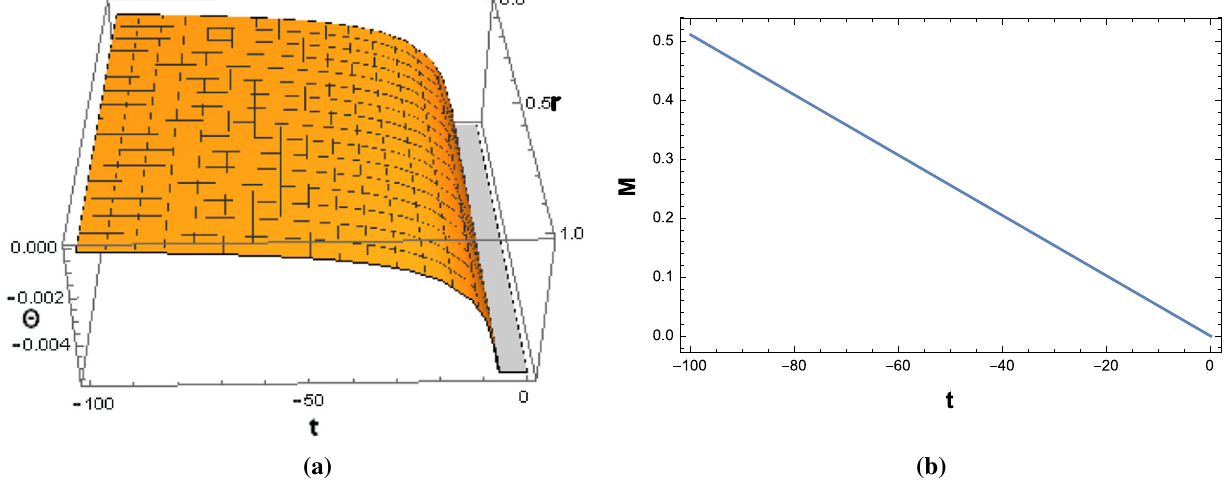
Fig. 5 a – c Shows the plots of the heat flux q (65) w.r.t. time t and radial r coordinates for f ( R ) = R + λ R 2 with λ = 5, f ( R ) = R 1 + (cid:3) with (cid:3) =